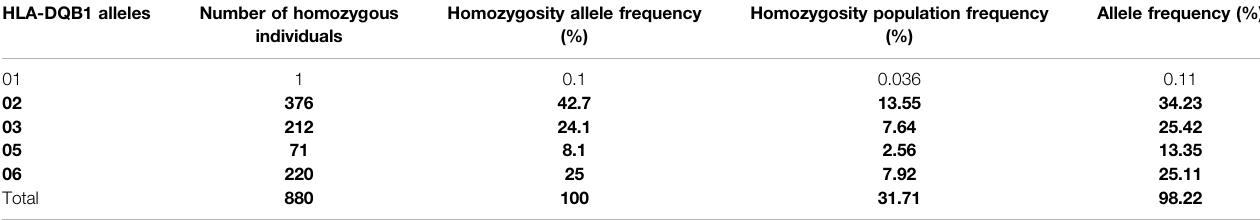
Bold values indicate the highest frequencies.